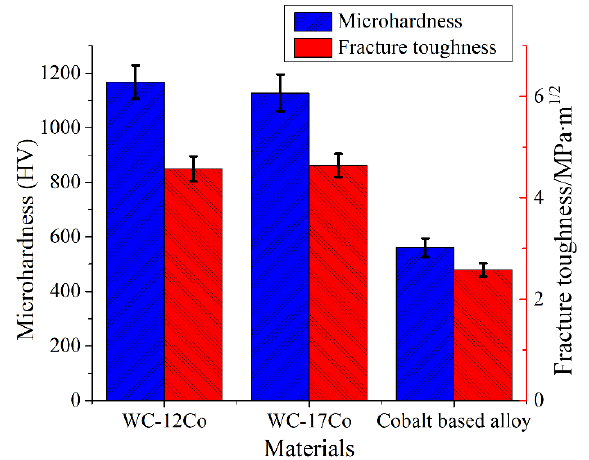
Figure 5. The microhardness and fracture toughness of the coatings.